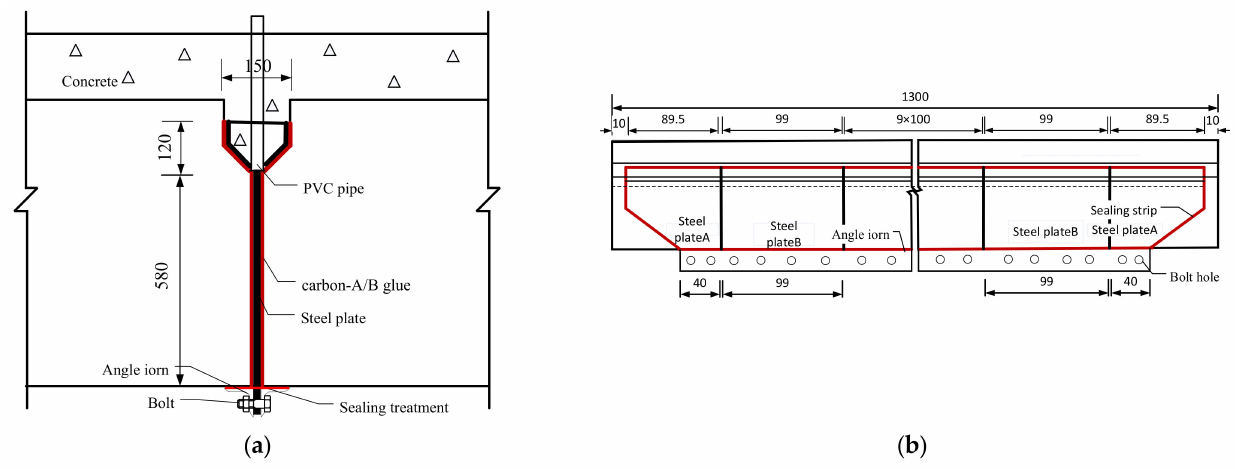
Figure 3. Details of inserting the steel plate. ( a ) Transverse section (mm). ( b ) Longitudinal section